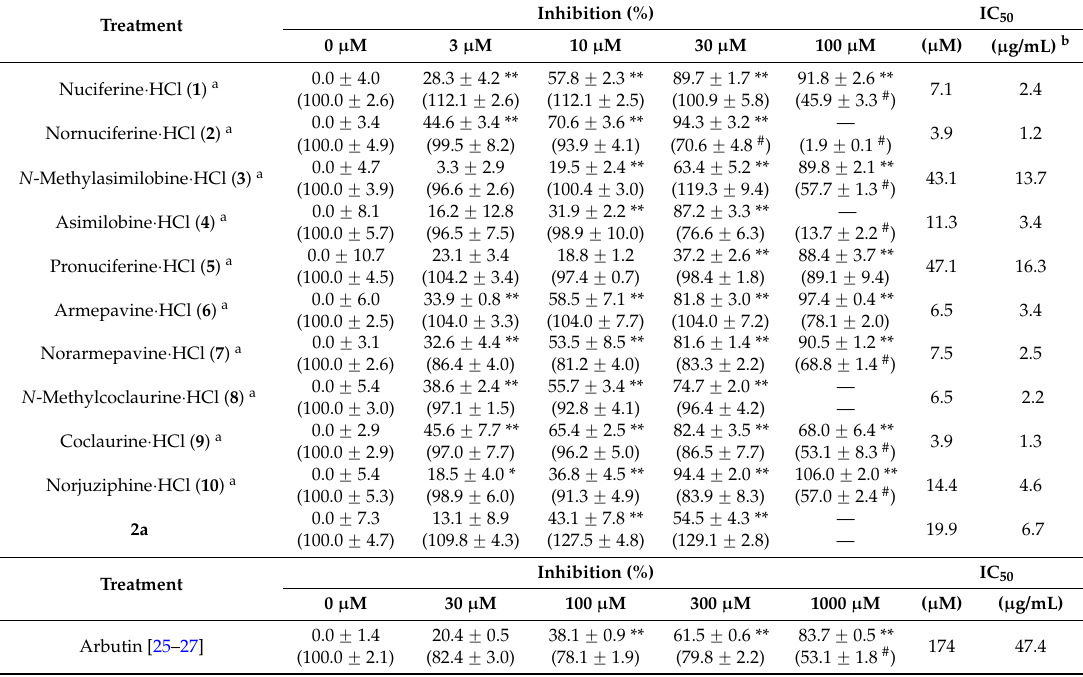
Table 7. Inhibitory effects of the alkaloids ( 1 – 10 ) and 2a on theophylline-stimulated melanogenesis and viability in B16 4A5